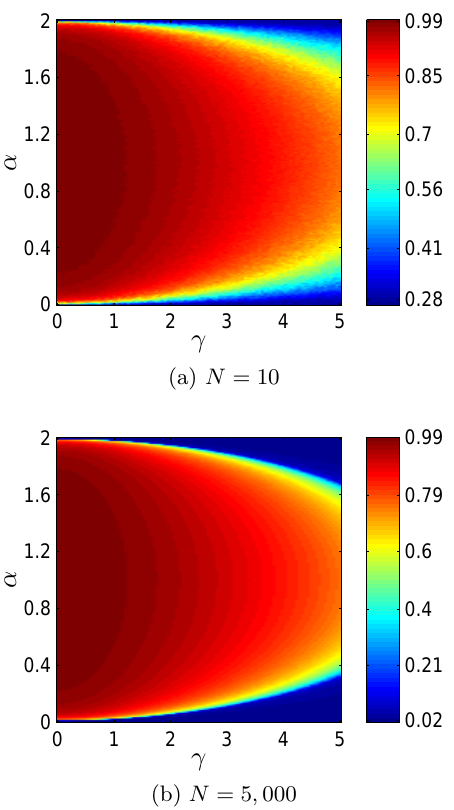
Figure 3: Polarization as a function of the jump frequency λ and the jump amplitude γ for (a) N = 10 and (b) N = 5 , 000 , where K = 2 , η = 0 . 1 , and α = 1 . 71 .